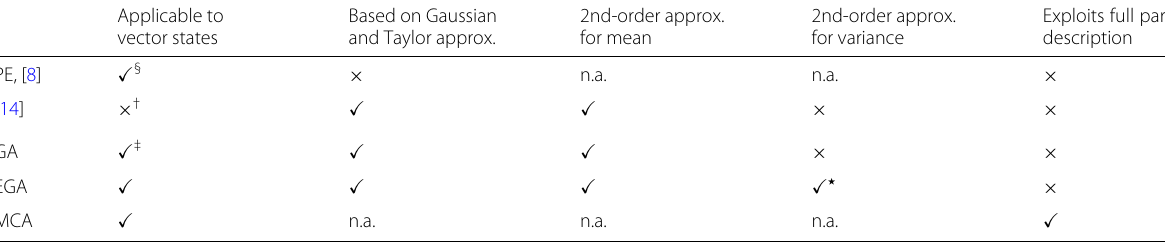
Table 1 Features of the considered likelihood approximation schemes Applicable to vector states